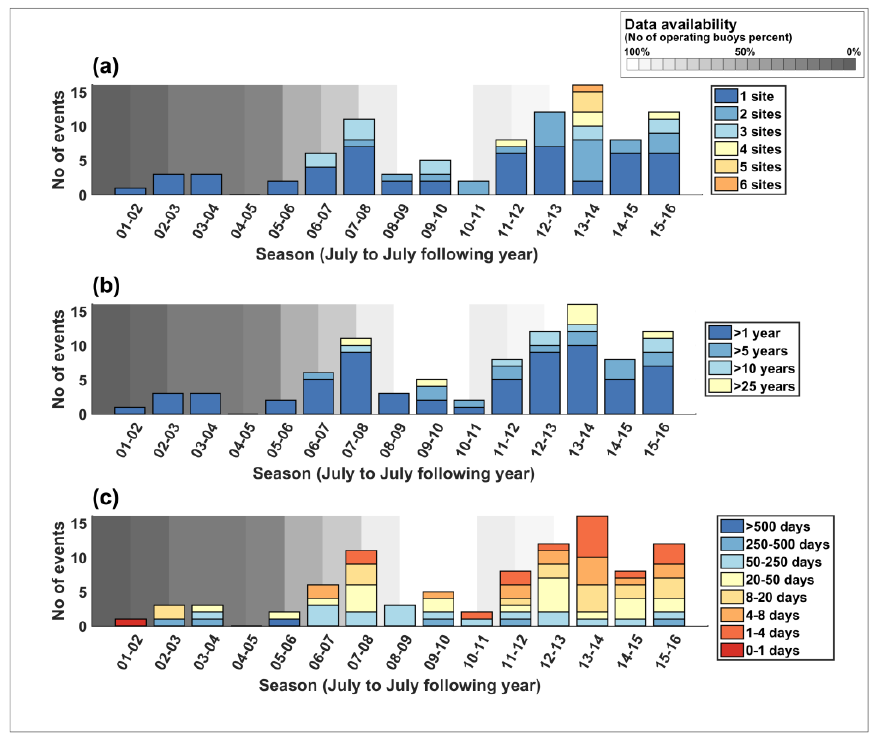
Figure 7. Number of significant wave height extreme events per season (July to July of the next year) for ( a ) distinct number of sites affected (i.e., spatial footprint), ( b ) different return level thresholds, and ( c ) ranges of days between events. The grey shading at the background represents the mean annual data availability: they lighter the grey, the more data are available. The number of events per month over the entire time series was examined, paying attention to the spatial footprints of the events, their maximum return period and the days between events. No